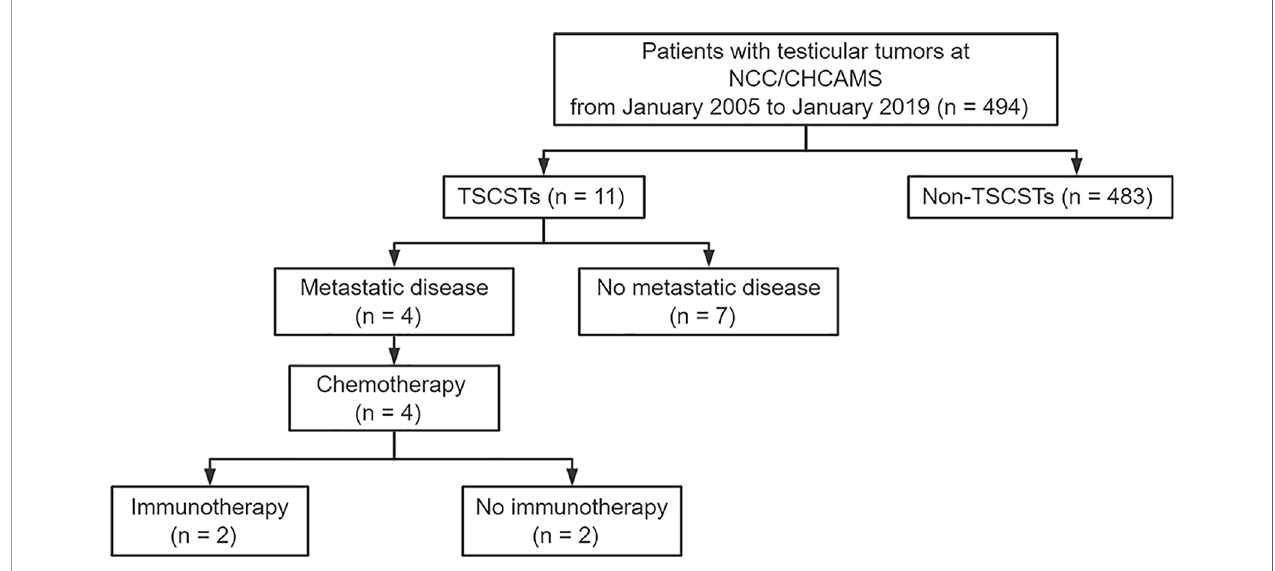
FIGURE 1 | Flowchart of screening patients. NCC/CHCAMS, National Cancer Center/Cancer Hospital, Chinese Academy of Medical Sciences; TSCSTs, testicular sex cord stromal tumours.